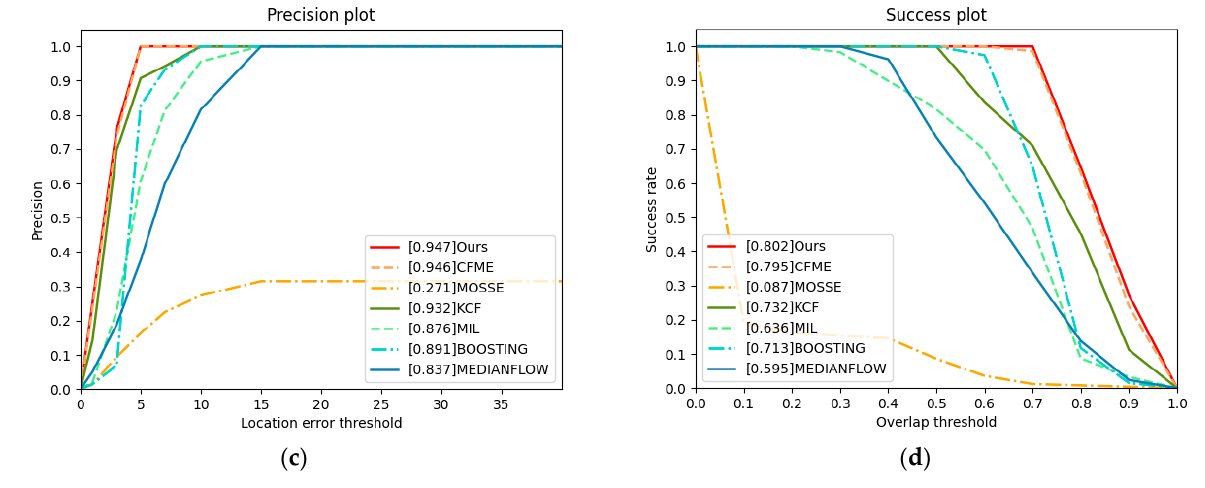
Figure 8. Precision plot and success plot. The values in legends are the AUC. ( a ) Precision plot of video1. ( b ) Success plot of video1. ( c ) Precision plot of video2. ( d ) Success plot of video2.